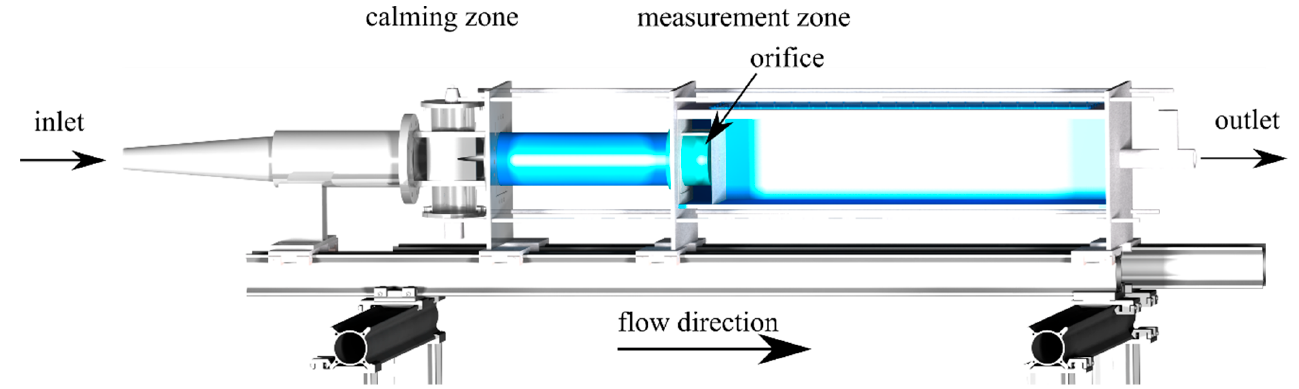
Figure 1. Schematic of the homogenization setup in the scaled experiments.